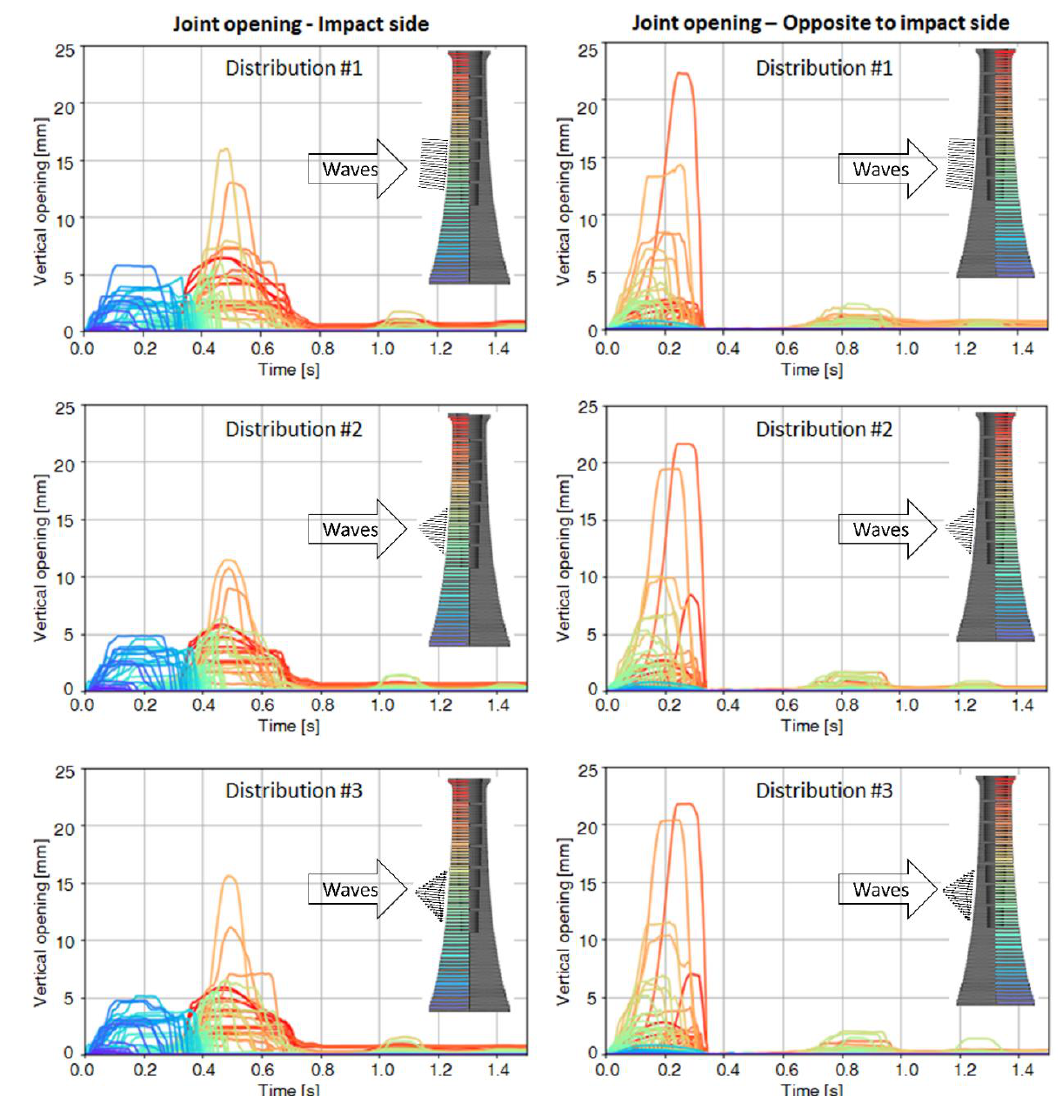
Figure 10. Opening of joints for the three distributions. Table 1. Maximum response values for the three pressure profiles.